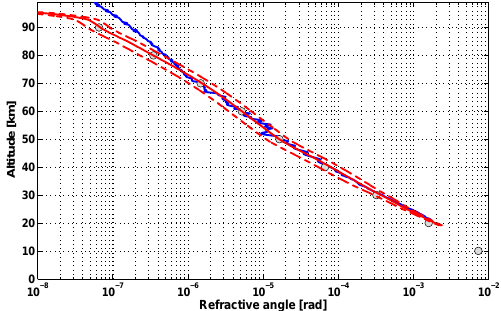
Figure 5. Refraction angle profiles retrieved using a single GOMOS occultation (star β Hyi, 22 July 2002, 10:21:53GMT, lat: 1 ◦ S, long: 176 ◦ E) from the red photometer (red thick line) with estimated er- rors due to photometer signals derived from Monte Carlo simula- tion (red dashed lines), from the GOMOS pointing measurement (in blue; notice that the GOMOS requirement for pointing stability was only “better than 40µrad” ) and compared with the analytical approximation (full circles) computed from Eq.